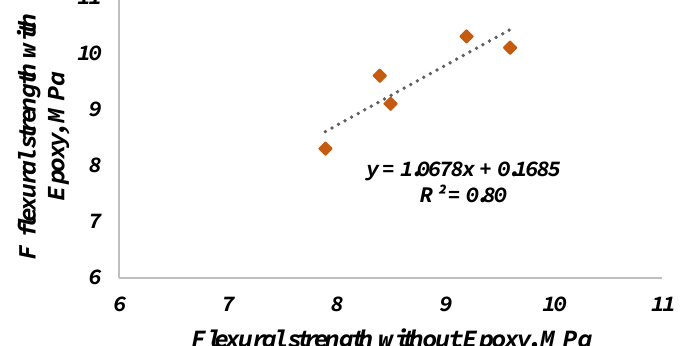
Figure 11. Correlation between the flexural strength of FRSCC before and after repairing with Epoxy.